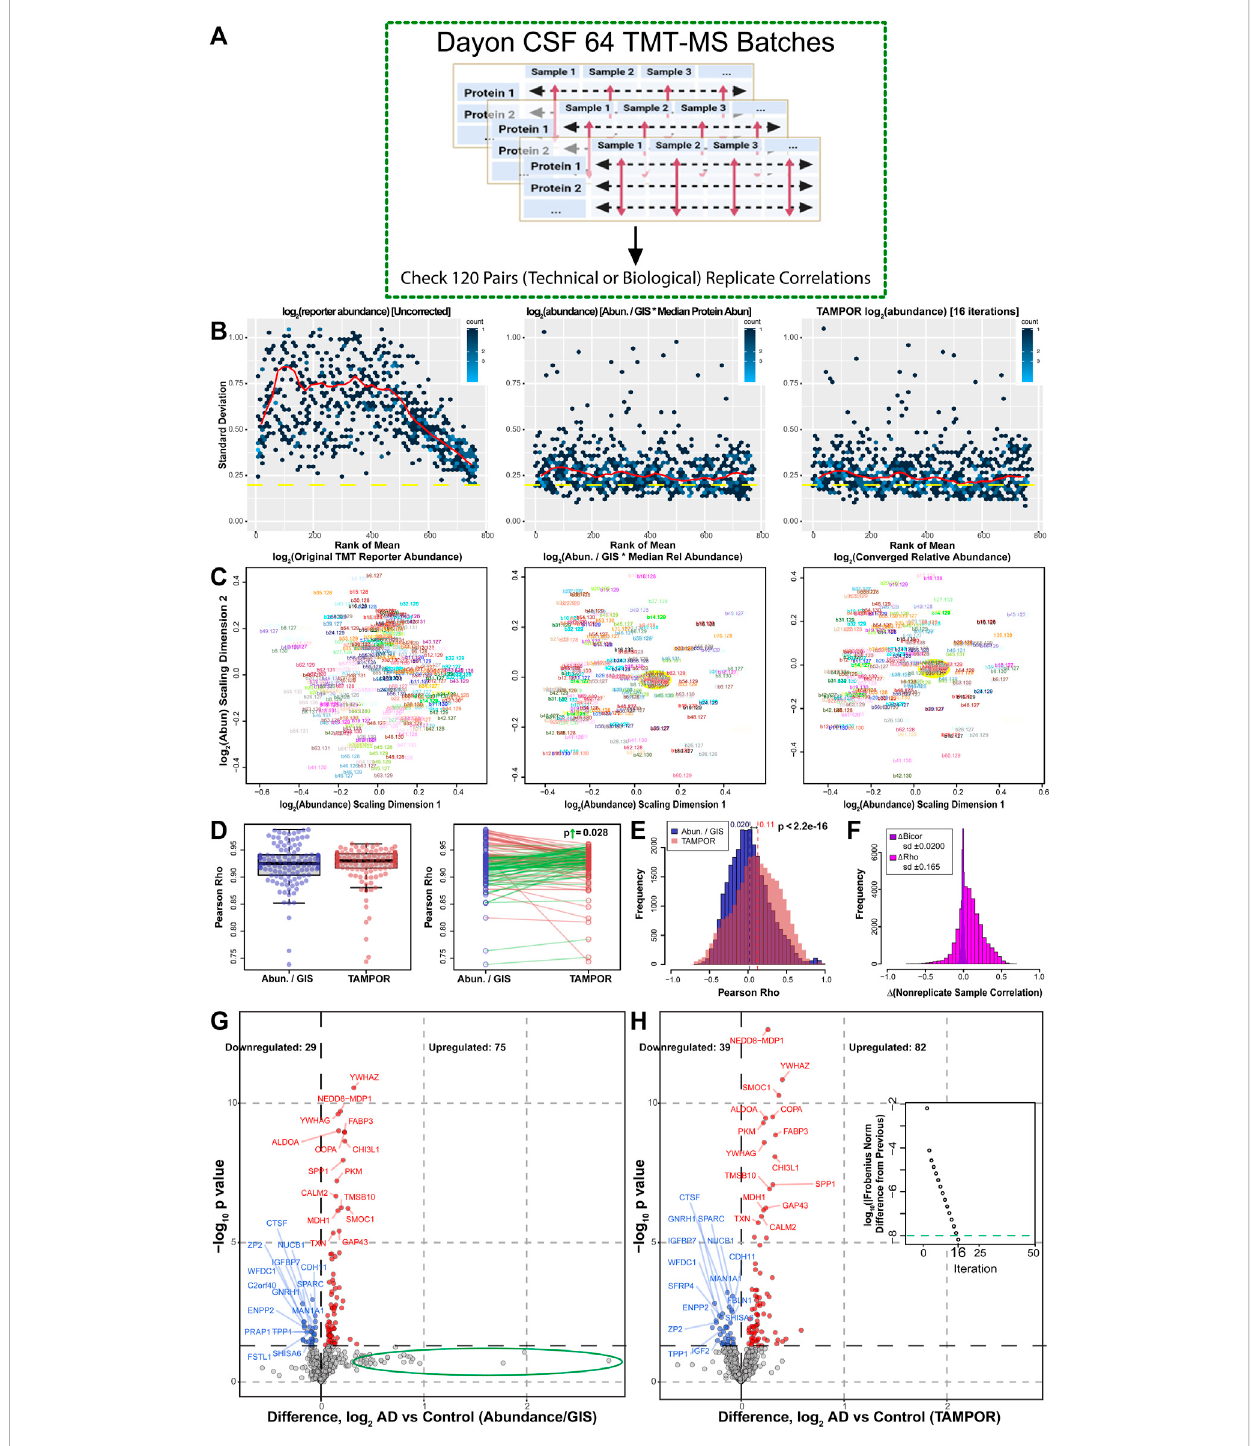
Usecase3:ComparisonofTAMPORversusnaïveratioof64batchTMT-MSCSFproteomics. (A) OnehundredandtwentycasesamplesofCSFwere analyzed by TMT-MS, each with atechnical replicate in adifferentbatch loaded equally by volume as published in (Dayon etal., 2018).Wereanalyzedthe publicly available raw data and performed a head-to-head comparison of naïve ratio of abundance/GIS intrabatch to TAMPOR abundance, paying special attention to replicate and non-replicate correlations in the data. (B) Mean-SD plots show variance in log 2 TMT abundance without ratio-based correction ( left ), with naïve ratio ( center ), and with TAMPOR ( right ). (C) MDS plots show changes in intersample variance from uncorrected TMT log 2 abundance( left ),tonaïveratio-correctedlog 2 abundance( center ),toTAMPORlog 2 abundance( right ).Yellowovalsinthecenterandrightpanelsindicate the location of GIS samples in the MDS plot near the plot origin or center. (D) The population median of Pearson correlation coef fi cients (rho) modestly increases in TAMPOR versus naïve ratio ( left ), and in comparisons of the same replicate pair ’ s correlation coef fi cients with naïve ratio-based correction (blue) and after TAMPOR (red), right . Sixty two green segments connect pairs increasing in correlation, and 58 red segments connect ones decreasing in